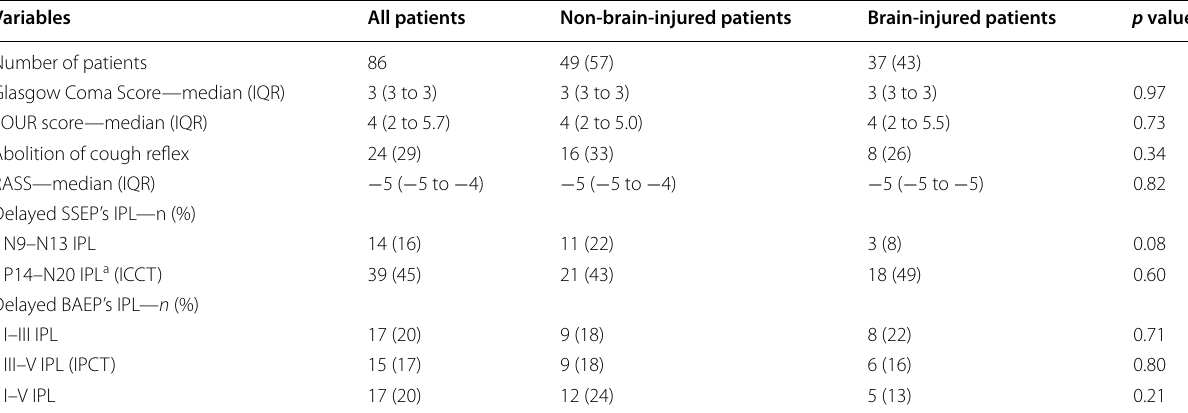
Table 3 Patient’s neurological and neurophysiological characteristics at time of inclusion